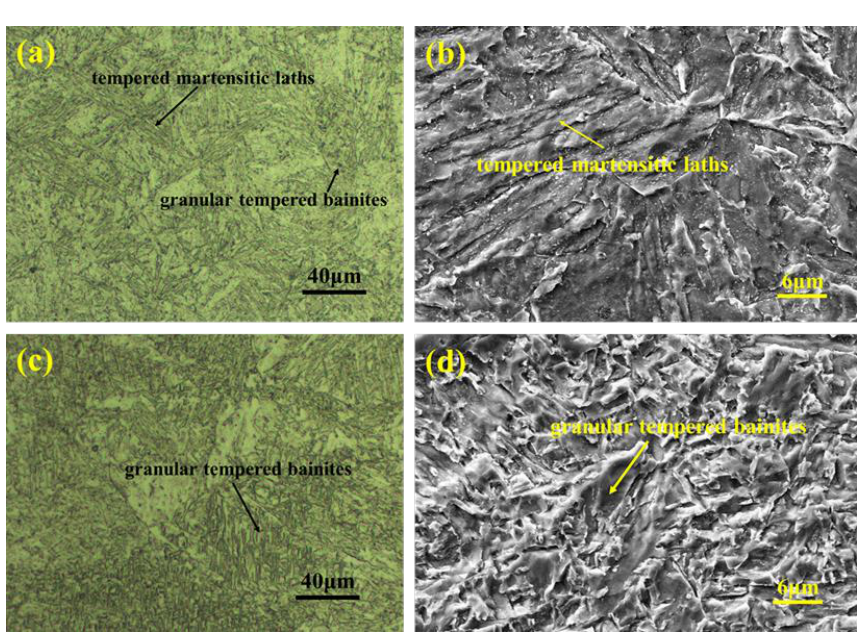
Figure 1. The typical microstructures in different zones of welded joints observed by optical mi- croscopy (OM) and scanning electron microscopy (SEM): base metal ( a , b ) and weld metal ( c , d ). Table 1. The chemical compositions of base metals and weld metals (in wt.%). Zone